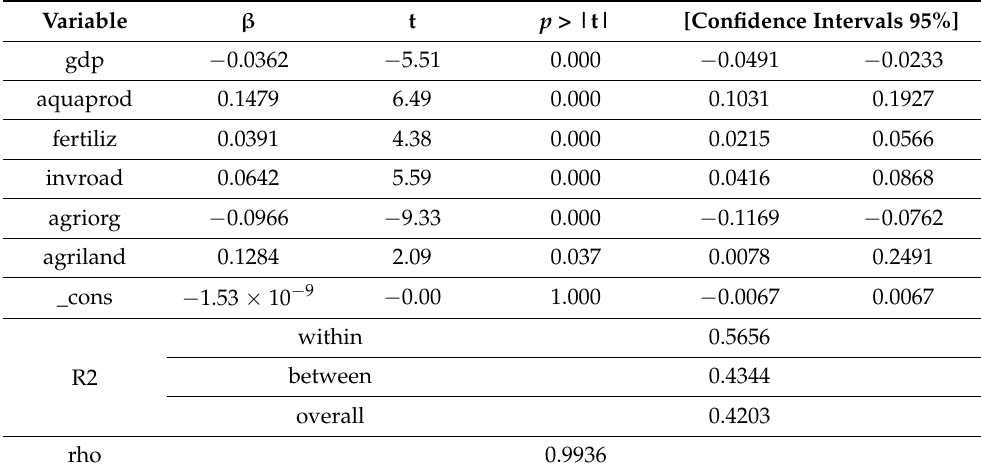
Table 1. Nonstandardized coefficients and characteristic values of the Fixed Effect